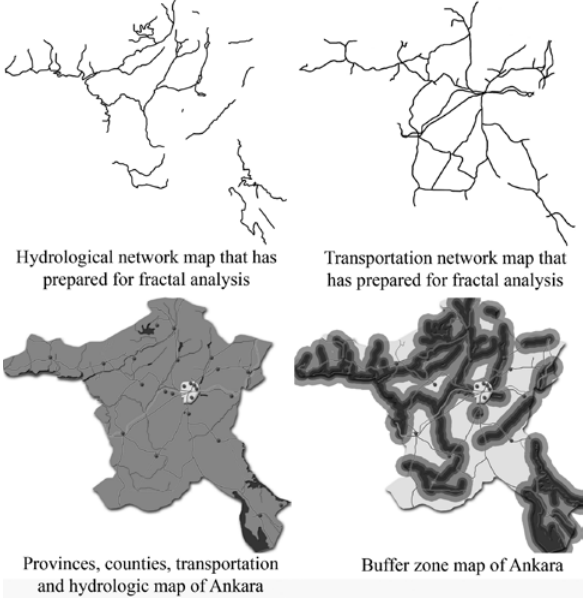
Fig. 1. The map of hydrology, road, province and county centers, Ankara city